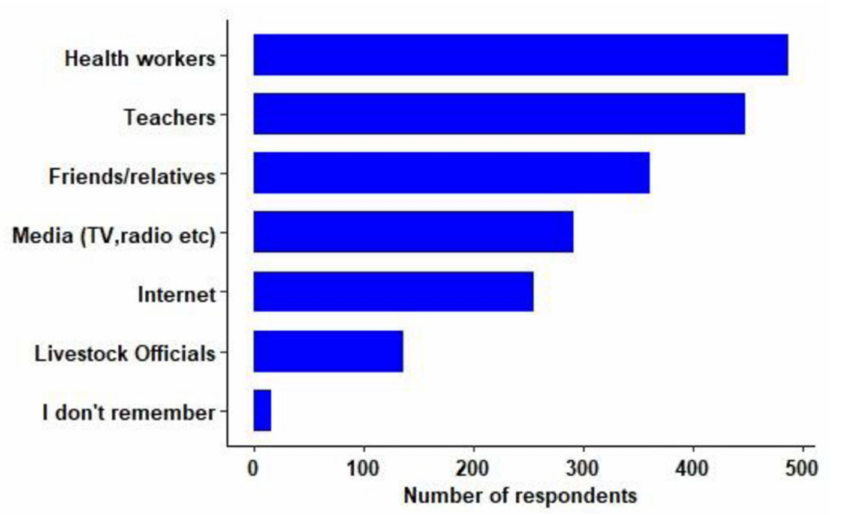
Figure 2. Sources of rabies information for the students of three secondary schools located in rabies endemic areas of south Bhutan (Phuntsholing, Gelephu, Garpowoong; n =